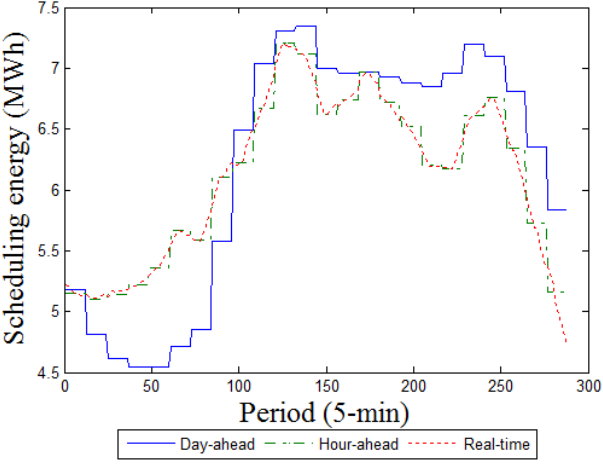
Figure 4. Energy scheduling at day-ahead, hour-ahead and real-time stages.